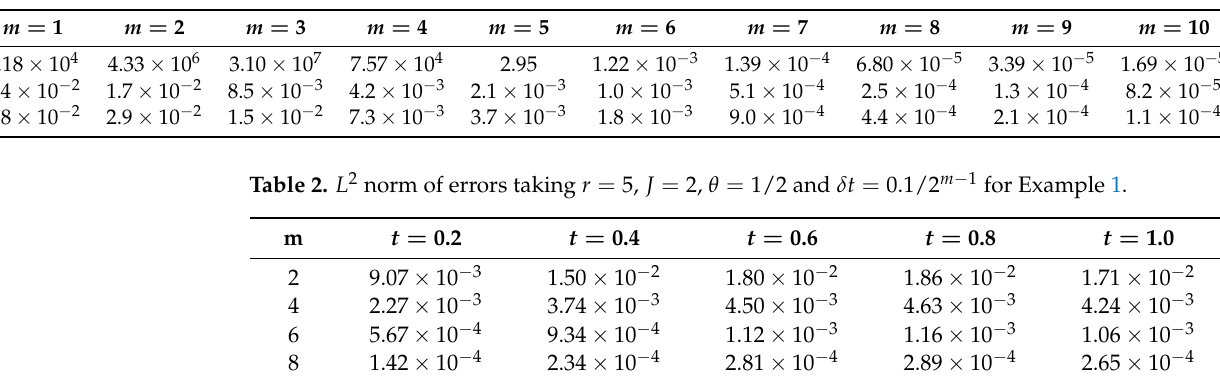
Table 1. Comparison of L 2 –error computed using explicit, implicit and Crank–Nicolson methods with time step size δ t = 0.1/2 m − 1 for Example 1.